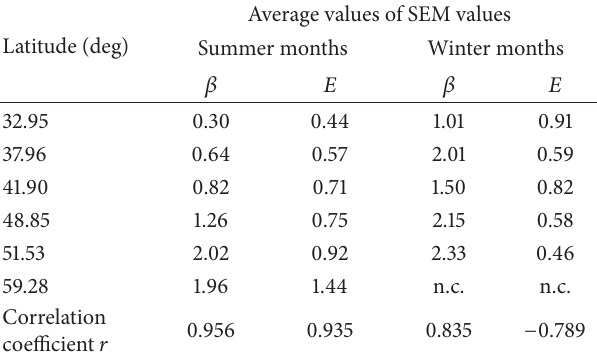
Table 8: The average standard error of the mean (SEM) of the tilt angles and of the monthly average of the daily global solar radiation values of diffuse solar radiation, computed separately for summer months (solar declinations 𝑑 4 – 𝑑 9 ) and for winter months (solar declinations 𝑑 1 – 𝑑 3 and 𝑑 10 – 𝑑 12 ) as a function of latitude (the correlation coefficient 𝑟 relative to winter months was computed excluding the values relative to the latitude of